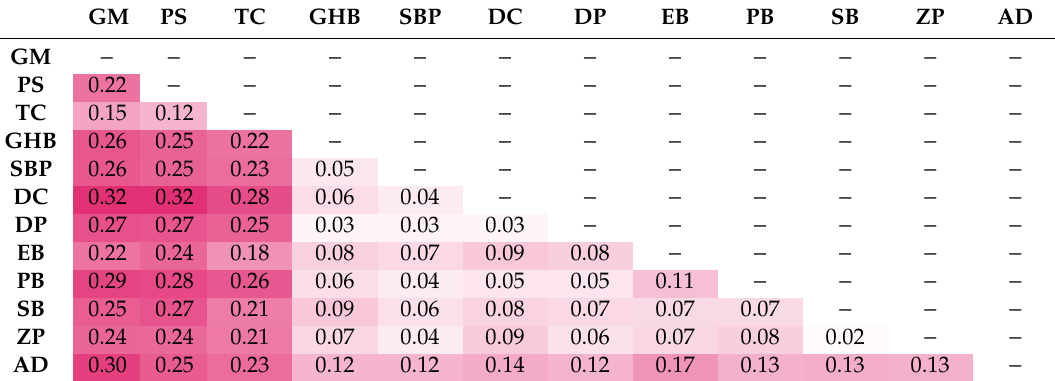
Table 2. Pairwise F ST values for nSSR data among all sampling locations based on Weir